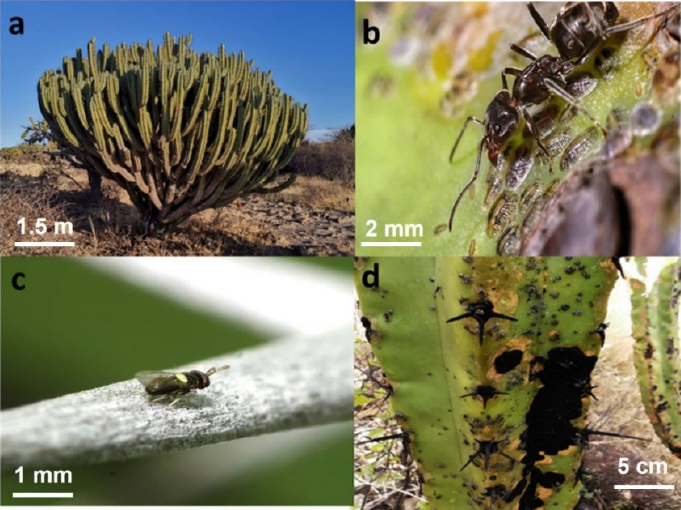
Figure 6. ( a ) Myrtillocactus geometrizans , ( b ) Liometopum apiculatum tending to Toumeyella martinezae, ( c ) Mexidalgus toumeyellus on M. geometrizans thorns and ( d ) branches of M. geometrizans showing damage, lignification, and presence of fungi due to the presence of T. martinezae . Images: Jesús Luna and Arturo Flores Callejas.